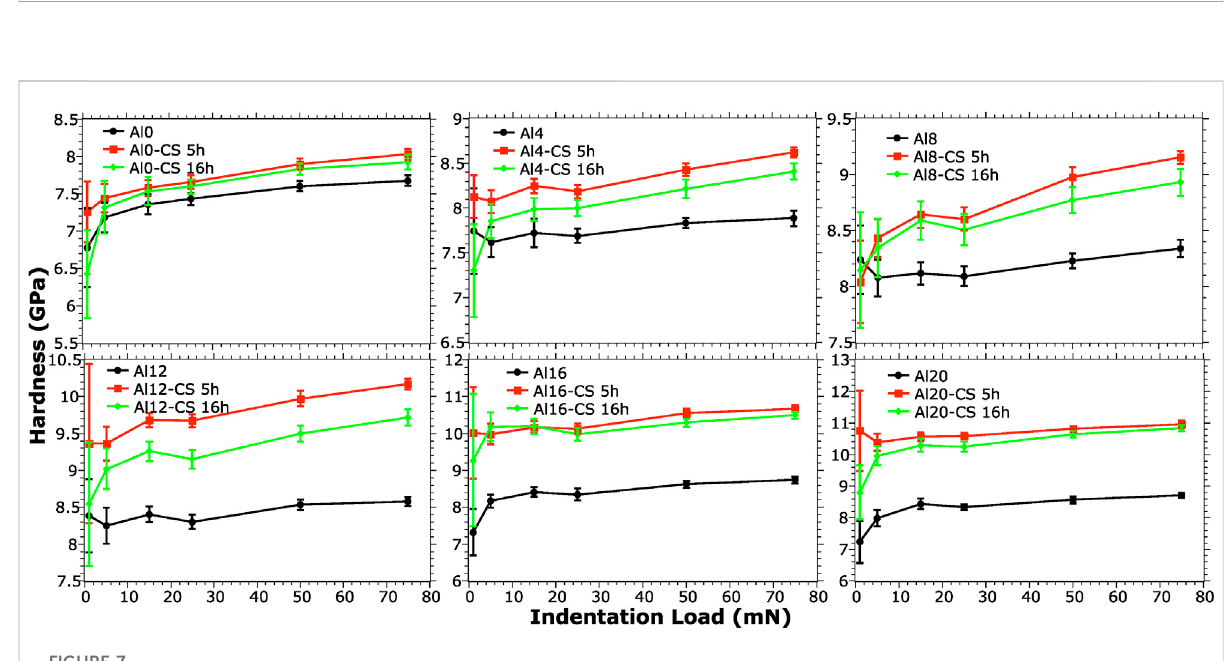
FIGURE 7 Hardness ( H ) as a function of indentation load for each sample, pristine and CS-glasses for 5 and 16h respectively. The solid lines are guides for the